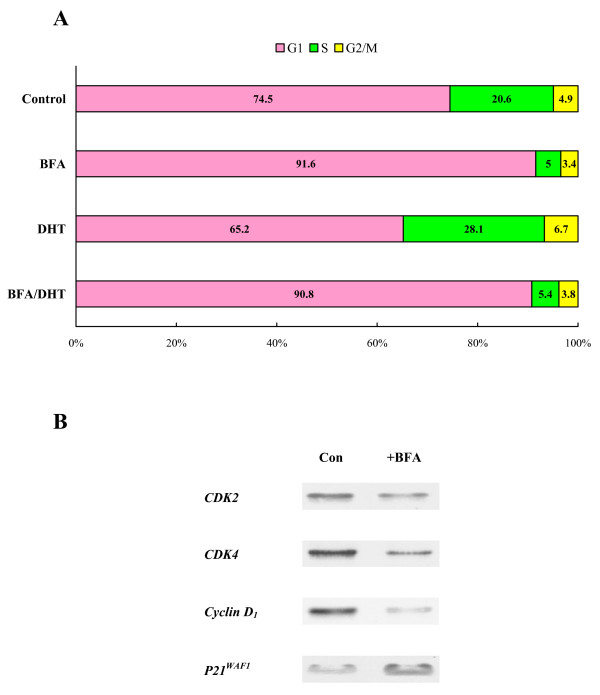
Effects of BFA on cell cycle. (A) LNCaP cells were treated with DHT (1 nM), BFA (30 ng/ml), or BFA/DHT combination for 72 h and cell cycle analysis was performed as described in Methods. Cell cycle phase distributions or the number (%) of cells present at the G1, S, or G2/M phases in each experimental condition was determined and plotted. The data were mean ± SD from three separate experiments and subjected to statistical analysis; however, only those mean values (without SD) were used for plotting the graph for a clear illustration. (B) After cells were treated with or without BFA (30 ng/ml) for 72 h, the expressions of specific cell cycle regulators such as CDK2, CDK4, cyclin D1, and p21WAF1 were analyzed on Western blots and autoradiographs of those regulators (on the X-ray film) are shown.